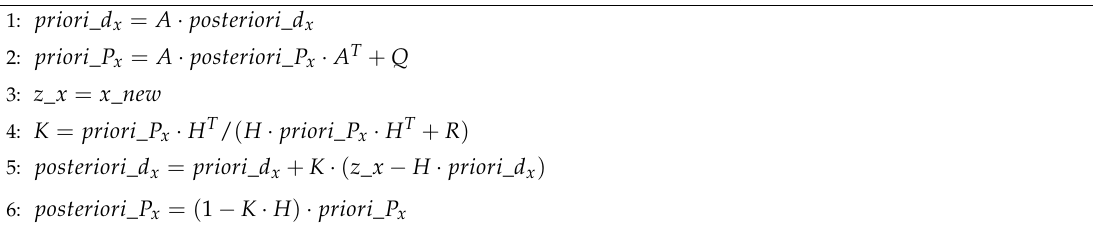
Algorithm 4 Use of the Kalman filter to compute displacement along the x